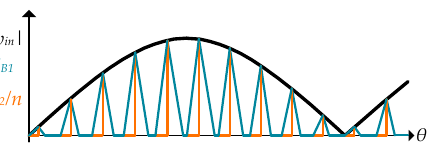
Figure 4. Proposed AC–DC DAB system.